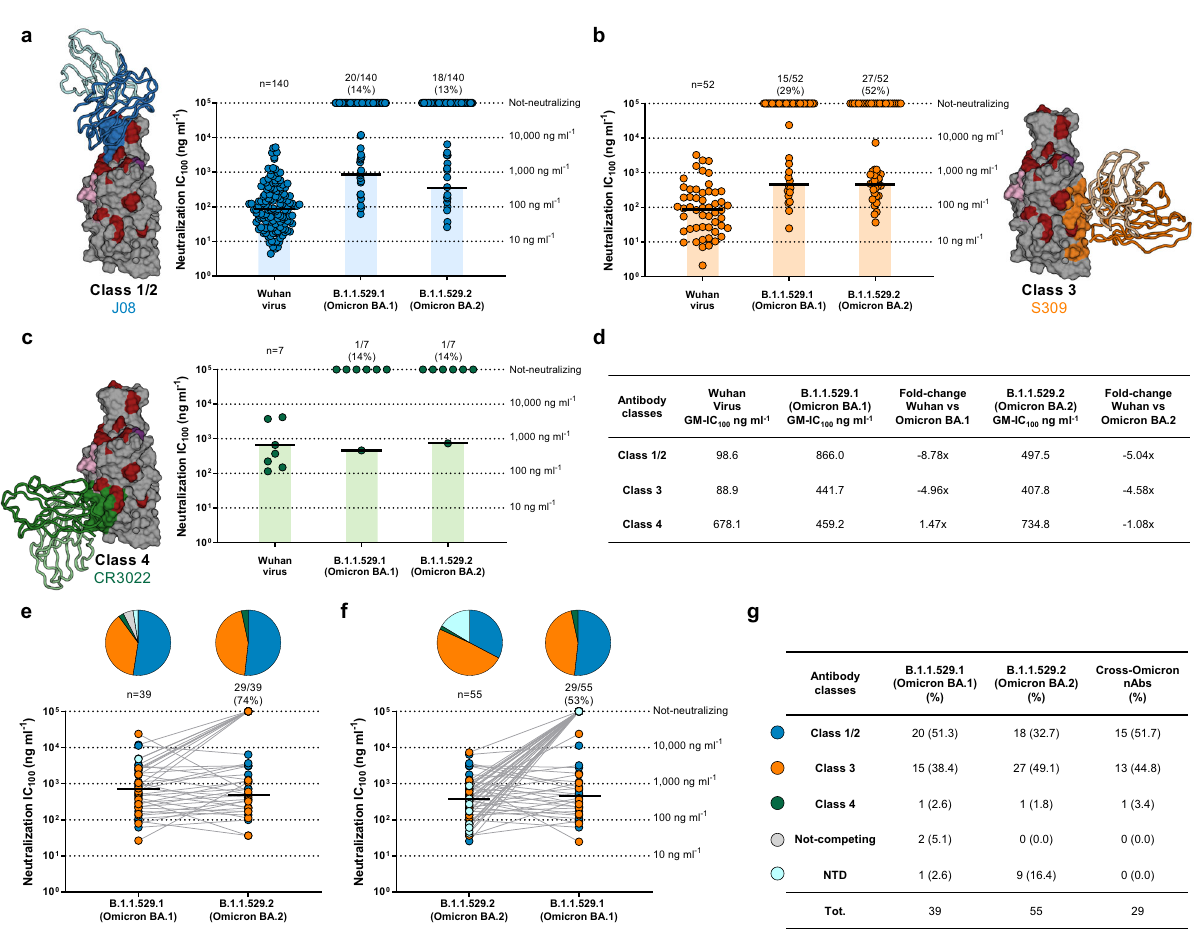
Fig. 2 Distribution of Omicron BA.1 and BA.2 nAbs. a – c Dot charts show the distribution of Class 1/2 ( a ), Class 3 ( b ) and Class 4 ( c ) nAbs against the original SARS-CoV-2 virus fi rst detected in Wuhan and the BA.1 and BA.2 Omicron VoCs. The number and percentage of nAbs and neutralization IC 100 geometric mean (black lines, light blue, orange, and green bars) are denoted on each graph. d The table summarizes the IC 100 geometric mean of nAbs against Wuhan, BA.1 and BA.2 VoCs and the GM-IC 100 fold-change between the Omicron variants and the ancestral Wuhan virus. e , f Dot charts show the neutralization potency, reported as IC 100 (ng ml − 1 ), of nAbs against Omicron BA.1 and their ability to cross-neutralize BA.2 ( e ) and of nAbs against Omicron BA.2 and their ability to cross-neutralize BA.1 ( f ). The number and percentage of nAbs and neutralization IC 100 geometric mean (black lines) are denoted on each graph. Pie charts show the distribution of nAbs based on their ability to bind Class 1/2 (blue), Class 3 (orange), and Class 4 (dark green) regions on the RBD, as well as not-competing nAbs (gray) and NTD-targeting nAbs (cyan). g The table summarizes number and percentages of Class1/2 (blue), Class 3 (orange), Class 4 (dark green) not-competing (gray) and NTD-targeting nAbs (cyan) for BA.1, BA.2, and cross-Omicron neutralize BA.1 and BA.2 respectively compared to the original Wuhan virus. IGHV1 – 69;IGHJ4-1 derived nAbs showed to be able to recognize both NTD and RBD, and to target Class 1/2 and Class 3 regions on this latter domain (Supplementary Fig. 4c, d). Conversely,